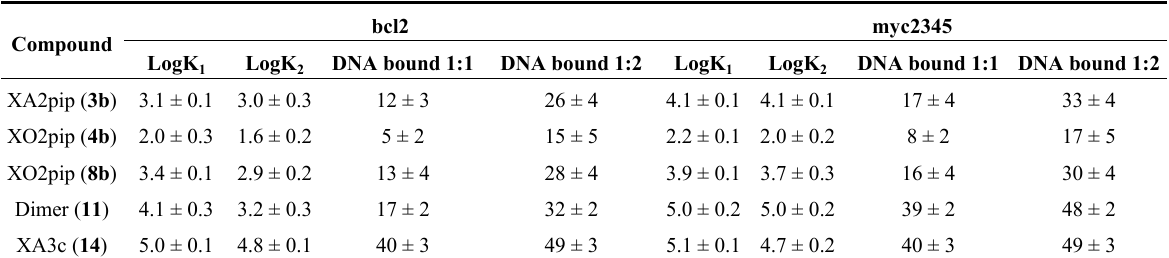
and K values (reported on a logarithmic scale) and percentage of bound DNA Table 4. K 1 2 calculated at 1:1 and 2:1 drug/DNA ratio for the indicated oligonucleotides, with standard deviations reported over at least three independent